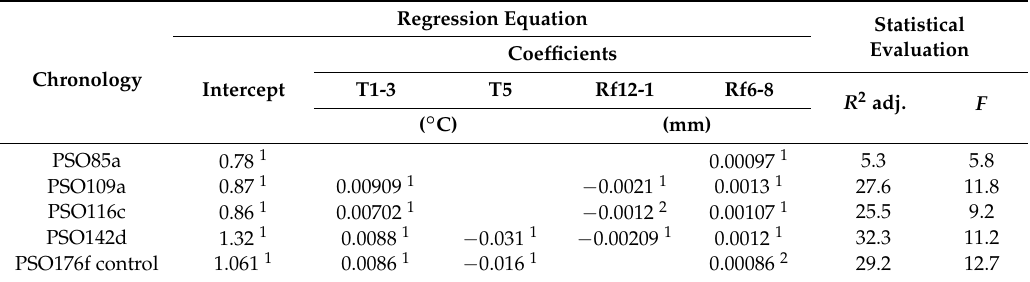
Table 6. Total influence of meteorological elements on residual site chronologies of Scots pine